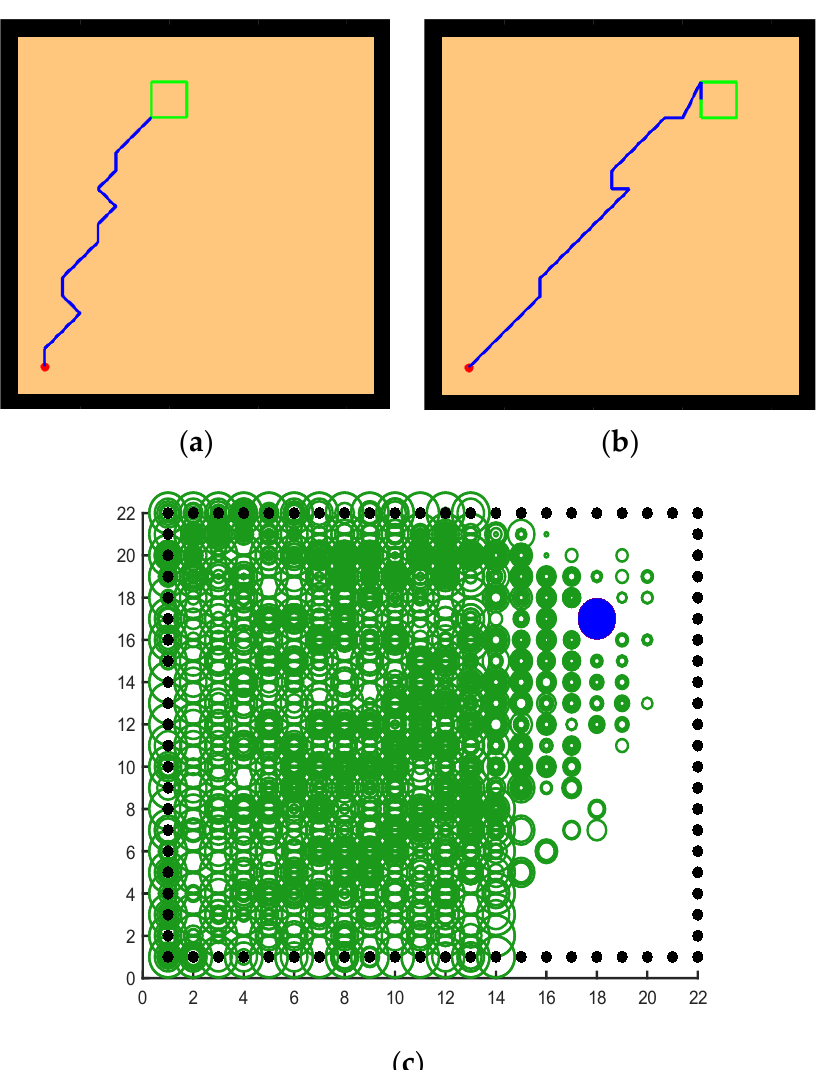
Figure 19. Performance of the brain-inspired model with olfactory system in the water maze exper- iment. ( a , b ) The calculated paths of the model when changing the position of the survival platform. ( c , d ) Signal propagation diagrams for navigation at different locations of the survival platform.